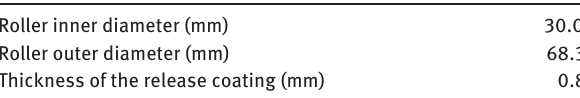
Table 1 Dimensions of the Coriolis Composites compaction